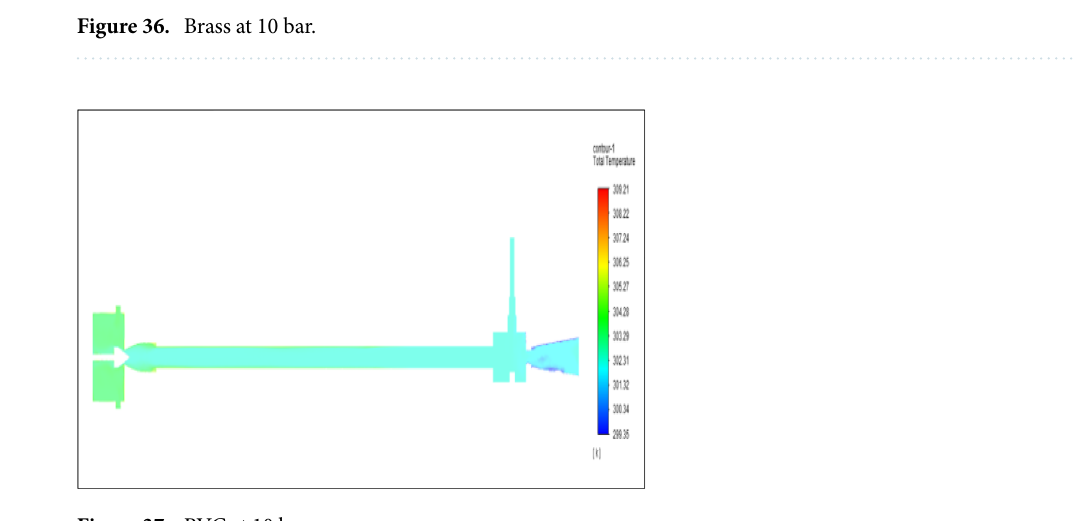
Figure 37. PVC at 10